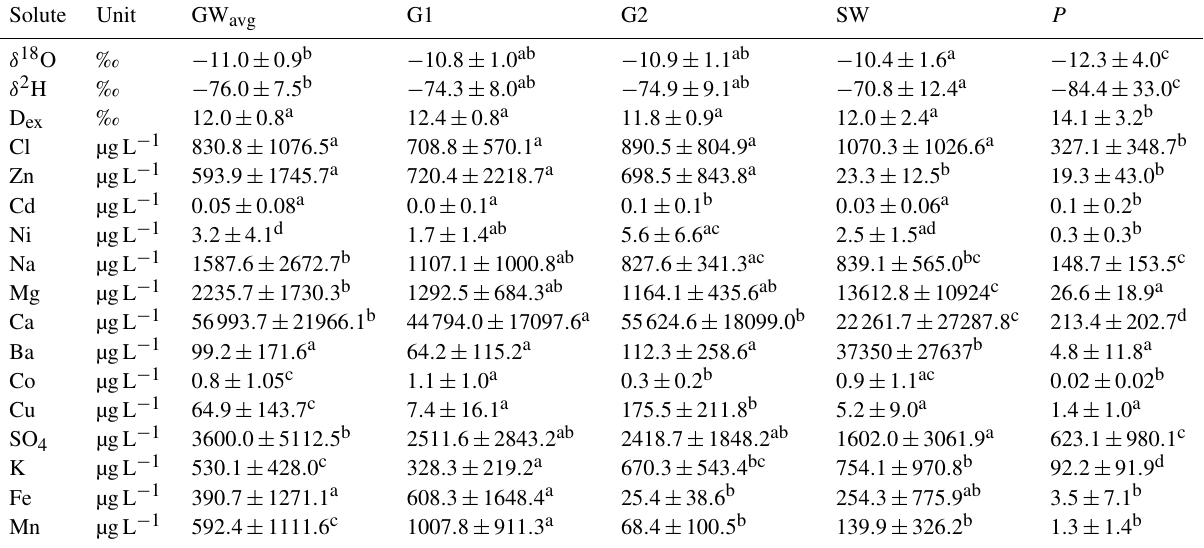
Table 2. Average concentrations ( ± standard deviation) for all groundwater (GW avg ; n = 335), all riparian groundwater (G1; n = 99), all hillslope groundwater (G2; n = 99), soil water (SW; n = 116), and rainfall samples ( P ; n = 156). Solutes are ordered by their respective groups (Sect. 4.3; Fig.